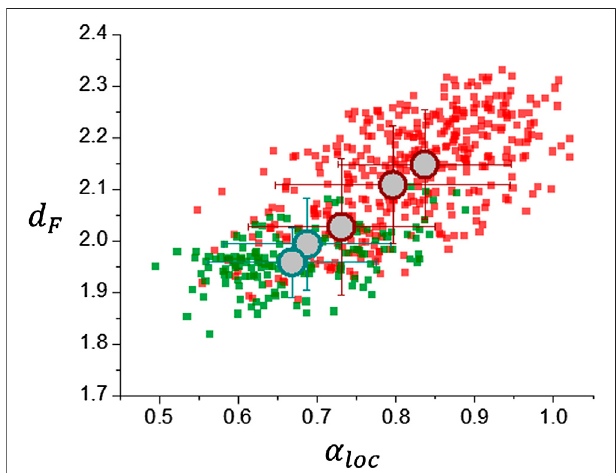
FIGURE 5 | Scaling analysis results for different brain tumor databases: Glioblastoma multiforme:TCGA-GBM and BraTS 2021, and Glioma: TCGA- LGG and REMBRANDT, are represented in red color; Meningioma and Acoustic Schwannoma correspond to local databases, represented in green color. Large circles indicate average values of data